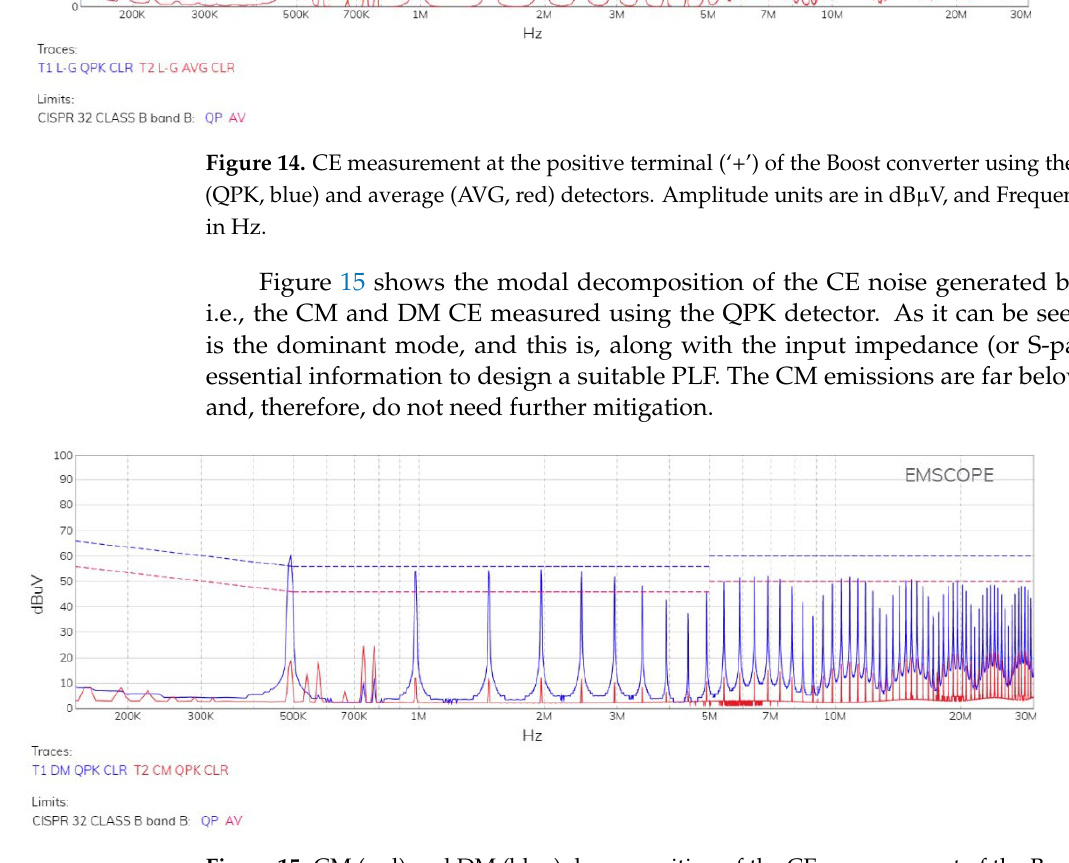
Figure 15. CM (red) and DM (blue) decomposition of the CE measurement of the Boost converter using the QPK detector. Amplitude units are in dBµV, and Frequency units are in